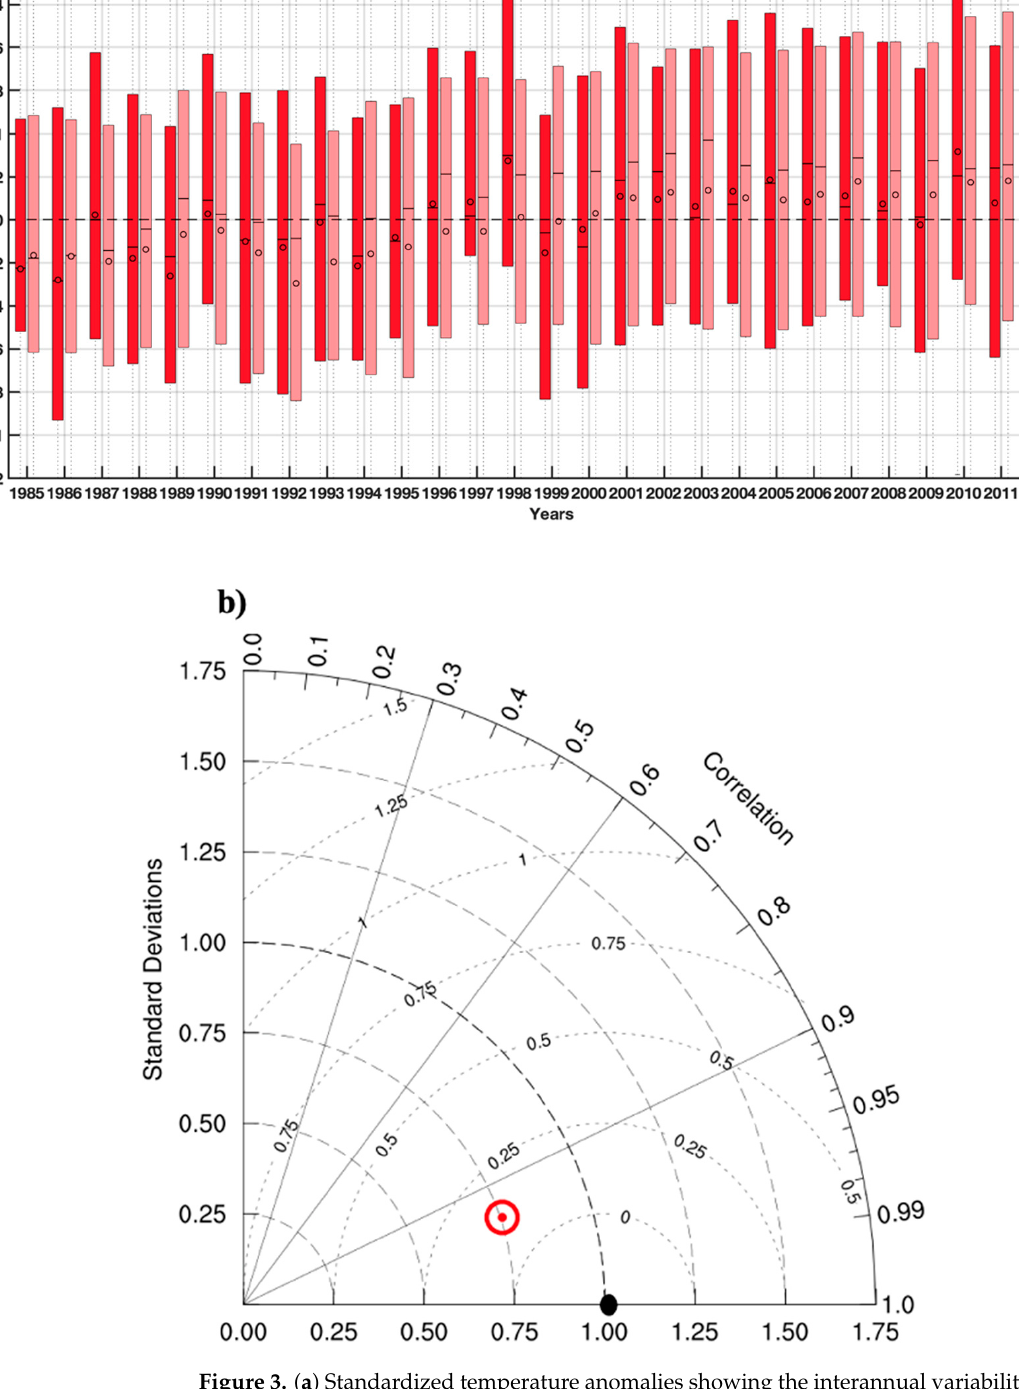
Figure 3. ( a ) Standardized temperature anomalies showing the interannual variability of temperature (dark red bars for the reference data WFDEI and light red bars for CMIP6 simulations). Boxes indicate the interquartile range and median of the ensemble, whilst the whiskers represent the 5th and 95th percentiles. ( b ) Standardized Taylor diagram displaying the statistics (coefficients, standard deviations and mean square errors) of temperature comparing multi-model ensemble mean of the bias-corrected CMIP6 with reference climate data (WFDEI). The multi-model ensemble mean of the bias-corrected CMIP6 compared is shown by the red cycle, and the WFDEI used as a point of reference is shown by the black dot point on the x -axis.